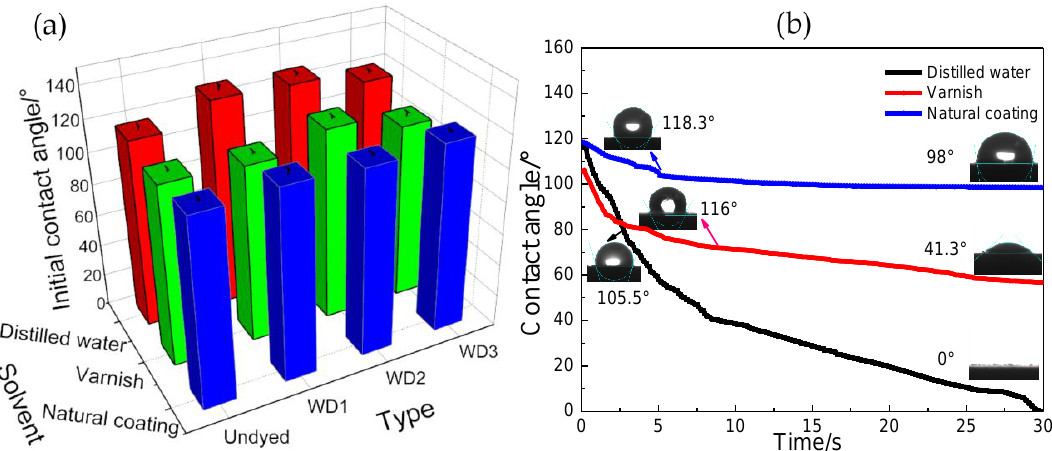
Figure 9. Initial contact angle ( a ) and typical dynamic contact angle curve ( b ) of poplar in different types and induction factors under the solvent of distilled water, varnish, and natural coating.